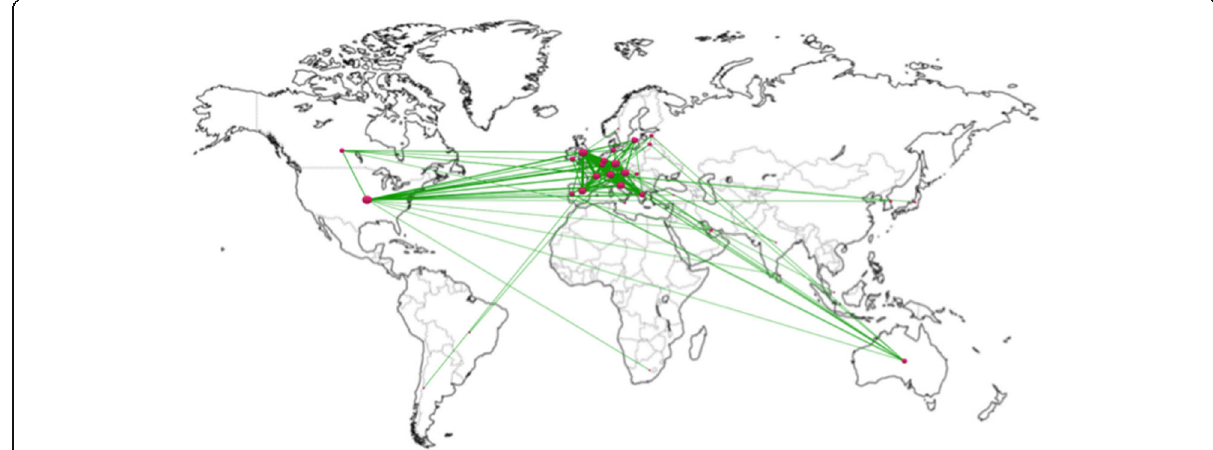
Fig. 6 World map of collaboration between